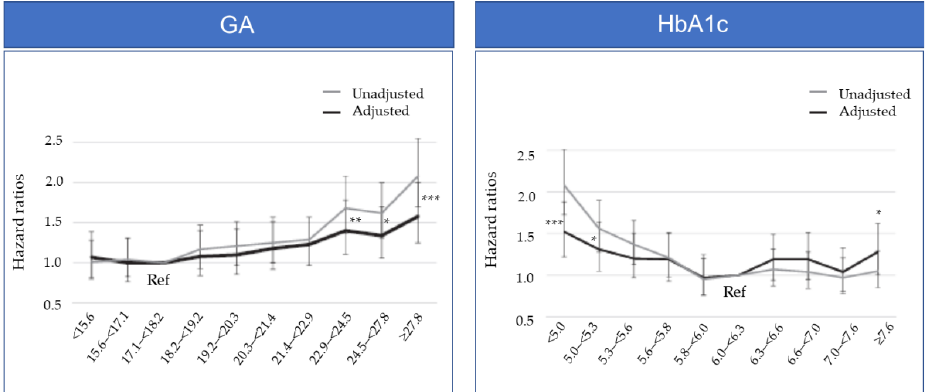
Figure 1. Hazard ratios of all-cause mortality divided by deciles of GA levels and HbA1c levels in 22,441 hemodialysis patients. Adjusted variables include age, sex, vintage, modality, body mass index, smoking, type of diabetes, antihypertensive agents use, type of hypoglycemic agent use, hemoglobin, albumin, C-reactive protein, parathyroid hormone, calcium, phosphate, high-density lipoprotein, Kt/V, normalized protein catabolic rate, history of cardiovascular disease, and type of dialysis center. * p < 0.05, ** p < 0.01, *** p < 0.001 vs. Ref. (Adjusted).